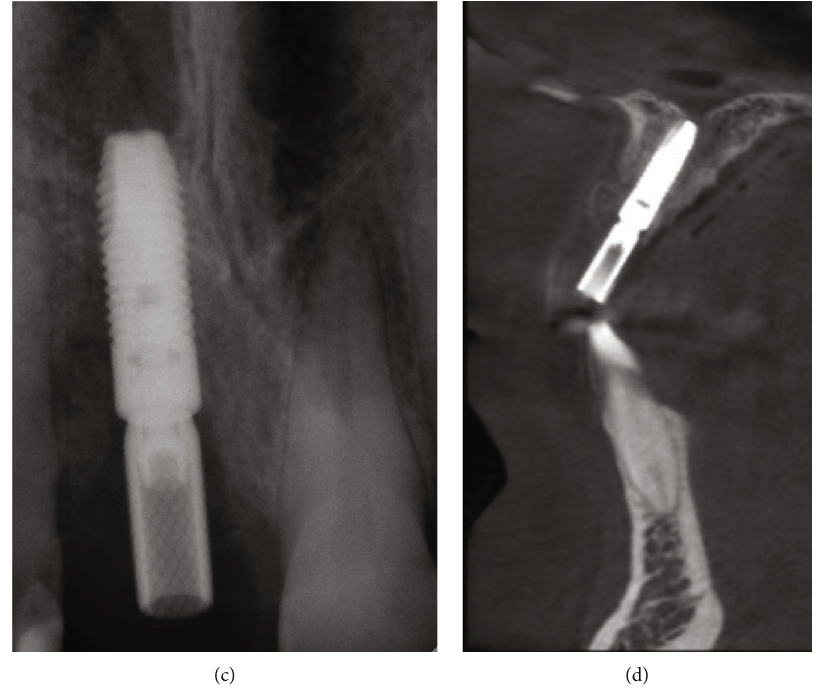
Figure 12: Day 5 — before and after suture removal. The laboratory provisional crown is fi xed.